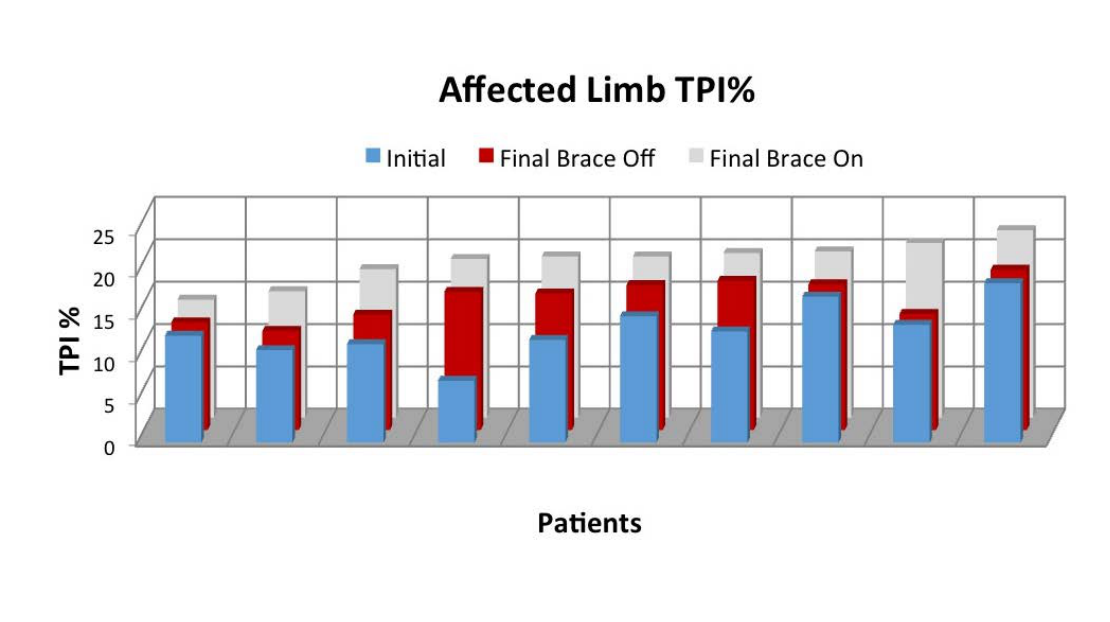
Figure 4: The TPI% in the Affected Limb of Each Individual Patient Over